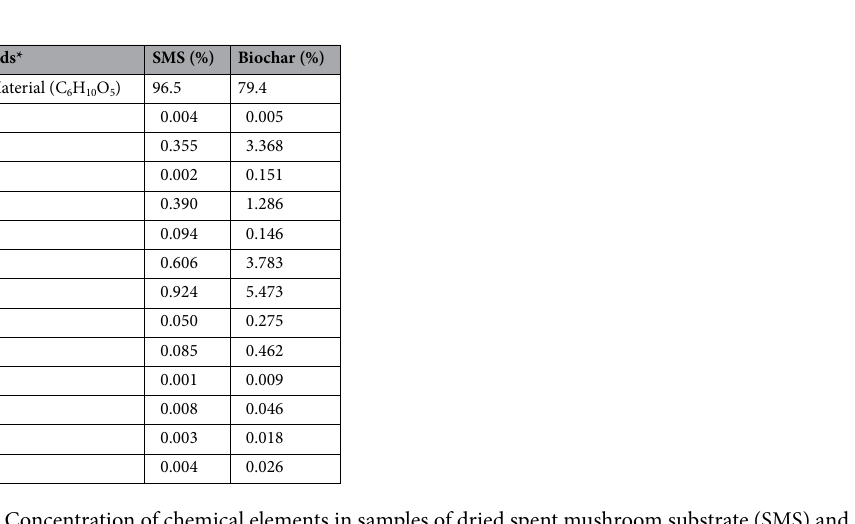
Table 2. Concentration of chemical elements in samples of dried spent mushroom substrate (SMS) and biochar after pyrolysis at 600 °C. *The lowest concentrations of compounds were not shown in the table.